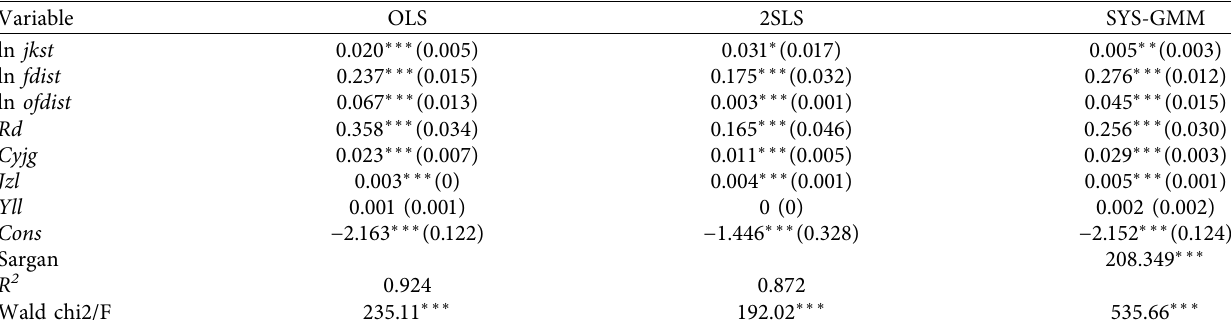
Table 8: Estimation methods robustness